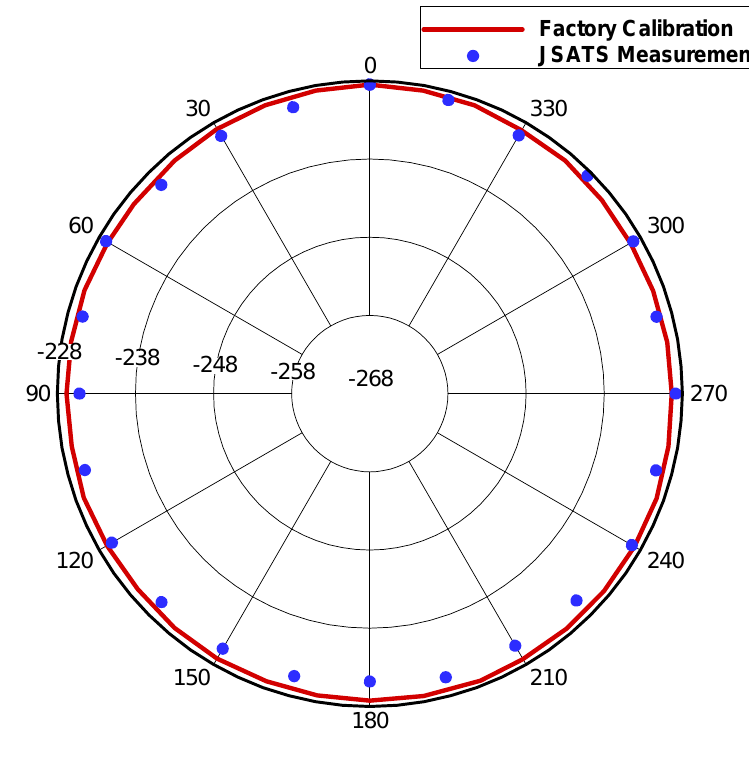
Figure 3. Comparison of the beam profile measured using the measurement and calibration system and factory-calibrated